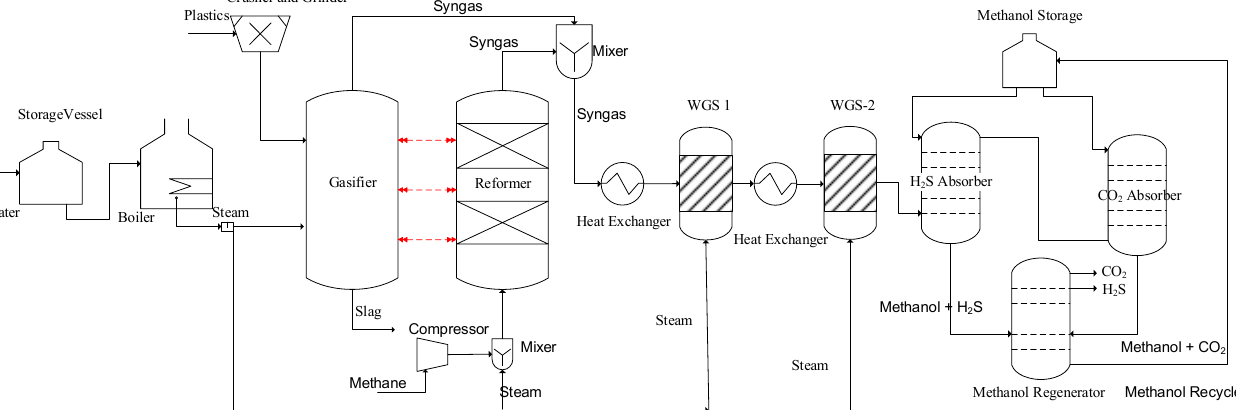
Figure 2. Hydrogen production from plastic waste gasification integrated with reforming (case 2).